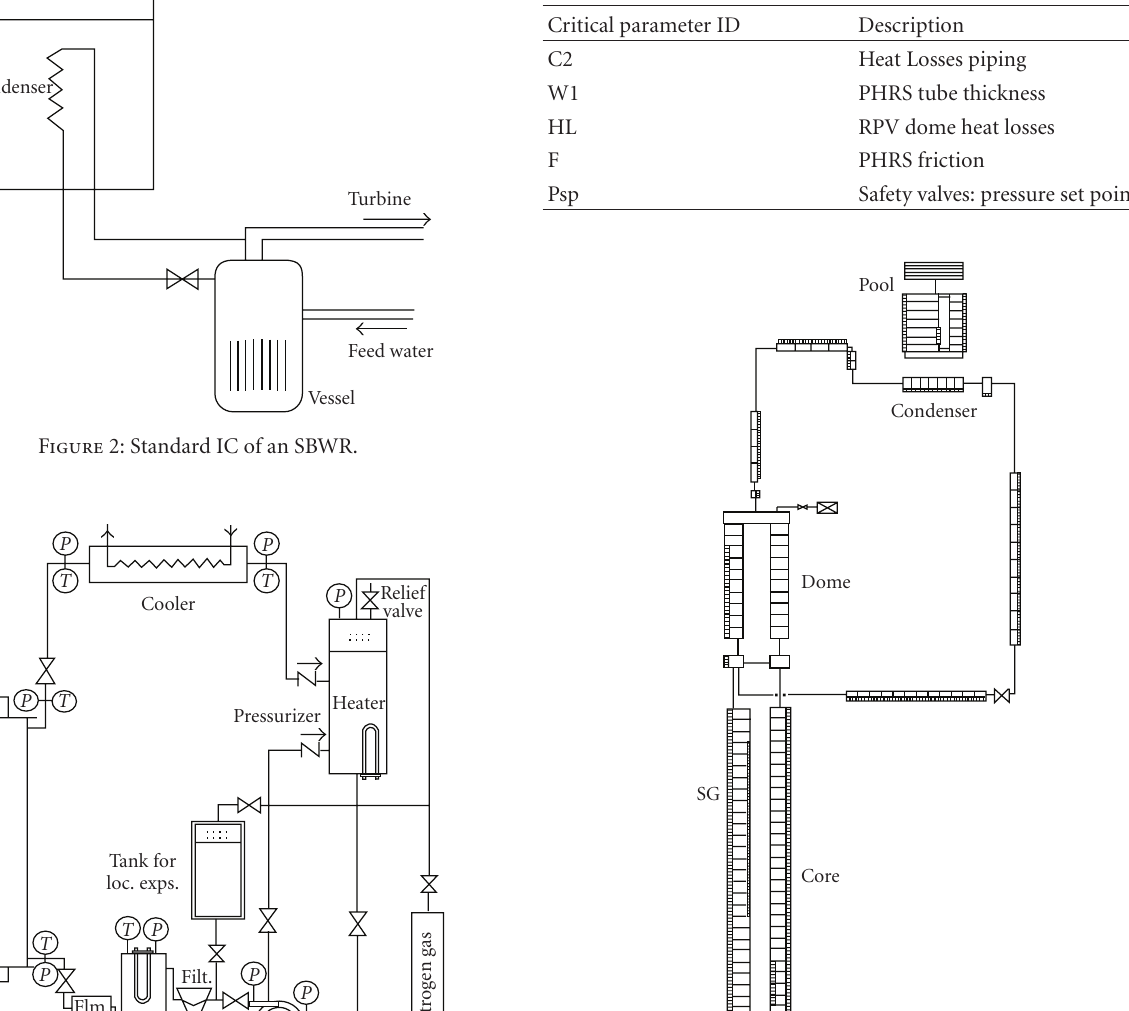
Table 2: Critical parameters case a.